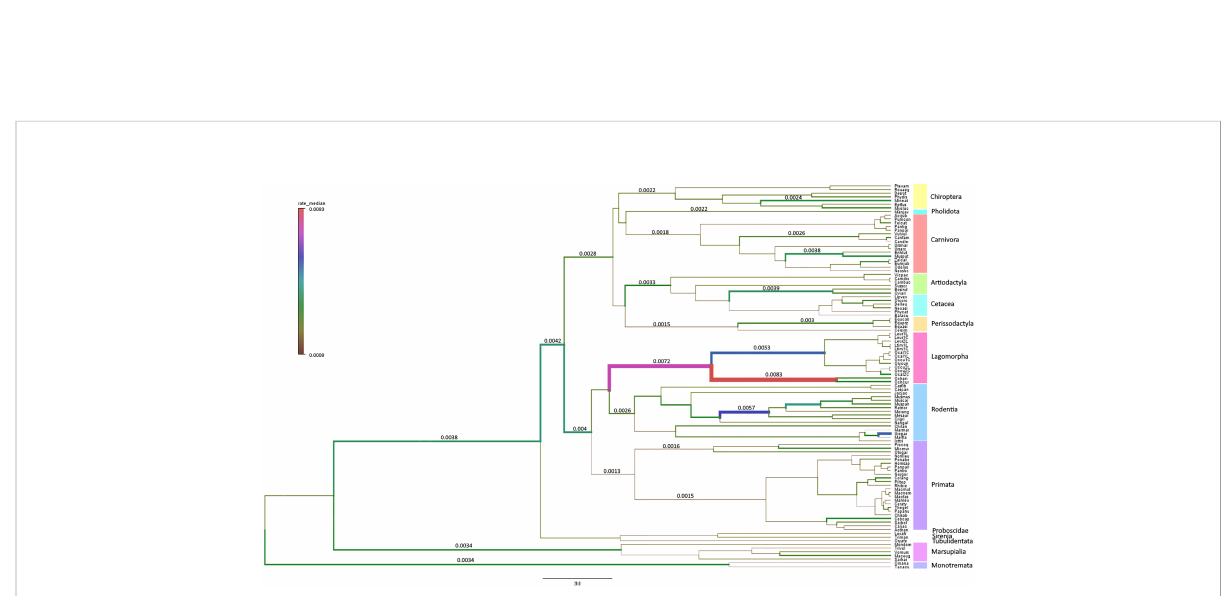
FIGURE 3 Branch-speci fi c evolutionary rates (substitutions/site/million years) for PIGR estimated using BEAST v1.10.4 (34). The median of the high posterior density distribution is mapped onto the mammalian phylogenetic tree. The thickness and color of branches vary according to the inferred rate. The mammalian orders are indicated in different colors in a vertical bar to the right of the tree.